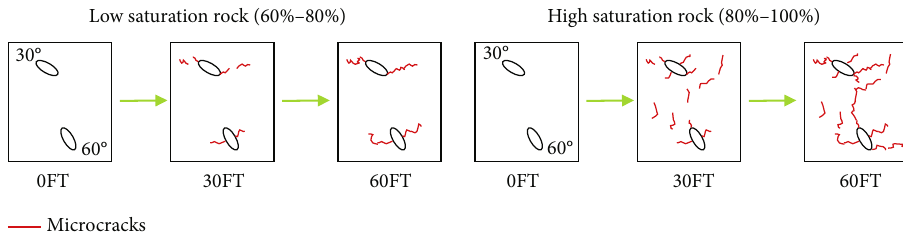
Figure 14: Damage evolution characteristics under the in fl uence of prefabricated